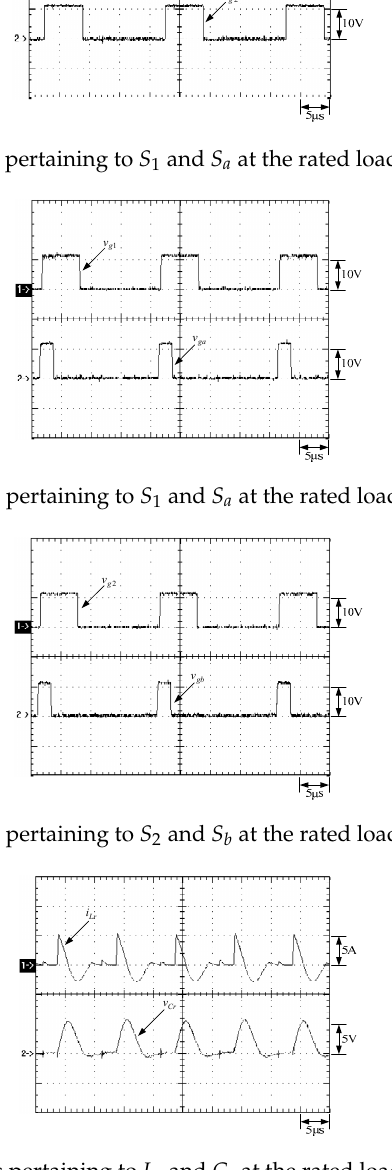
Figure 28. Waveforms pertaining to S 1 , L 1 and L r at the rated load: (1) v S 1 ; (2) i L 1 ; and (3) i Lr .